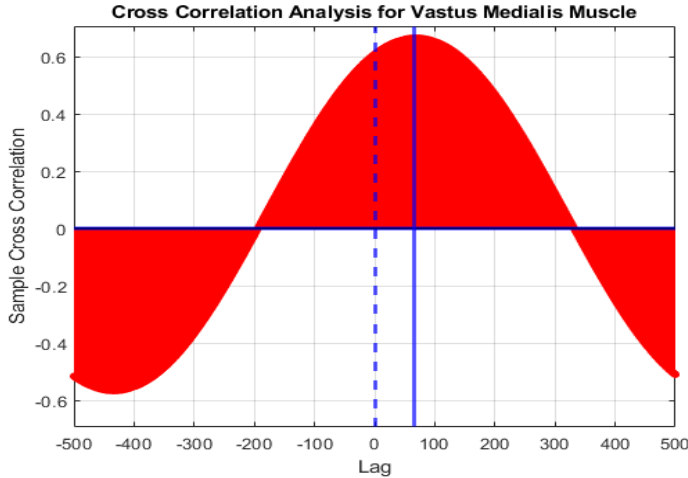
Figure 5. Cross-correlation (CC) of the sEMG signal of vastus medialis muscle.